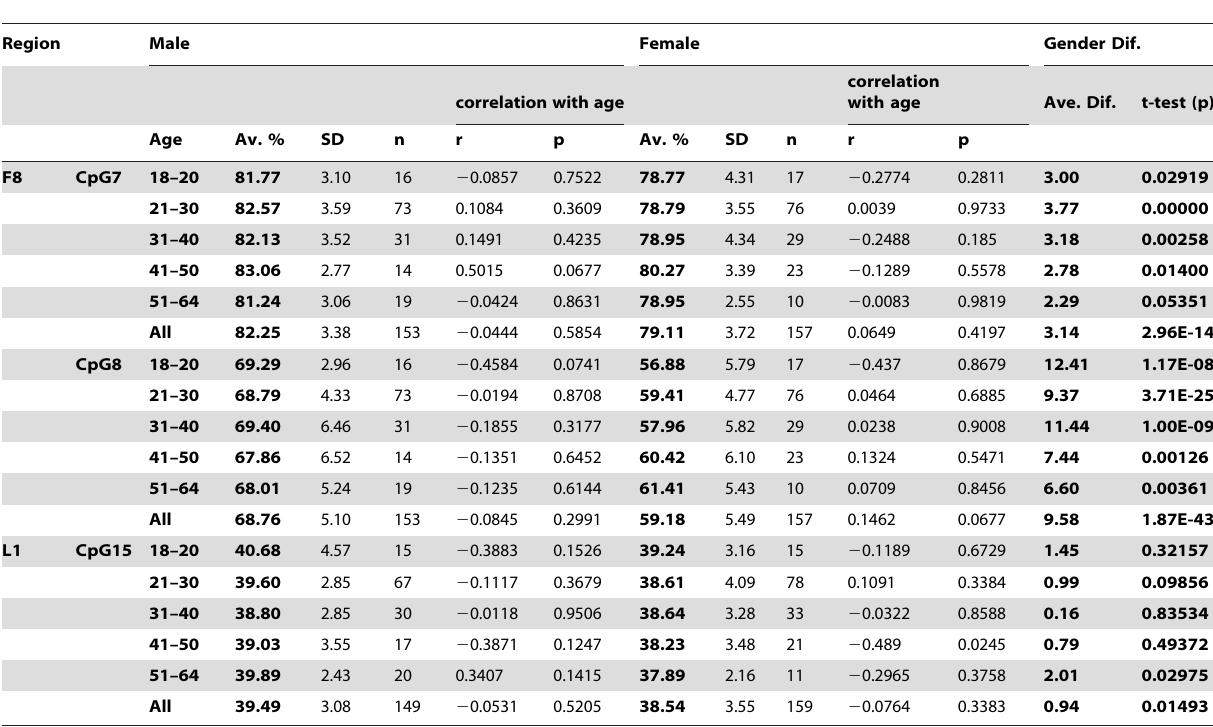
Table 1. Methylation at Line-1 and F8 and its correlation with gender and age.